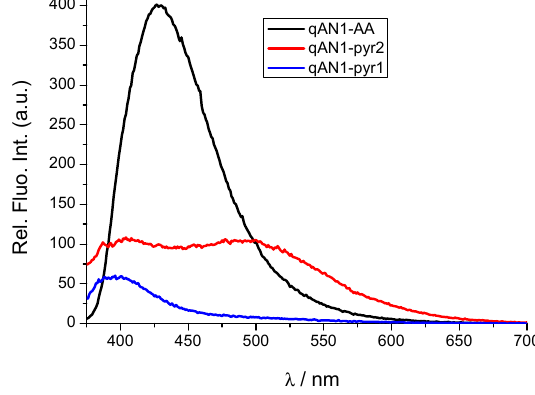
Figure 2. Fluorescence spectra of qAN1-AA and pyrene conjugates qAN1-pyr1 and qAN1-pyr2 ( λ exc = 350 nm, c = 1 µM) in sodium cacodylate buffer (pH 7.0, I = 0.05 M).